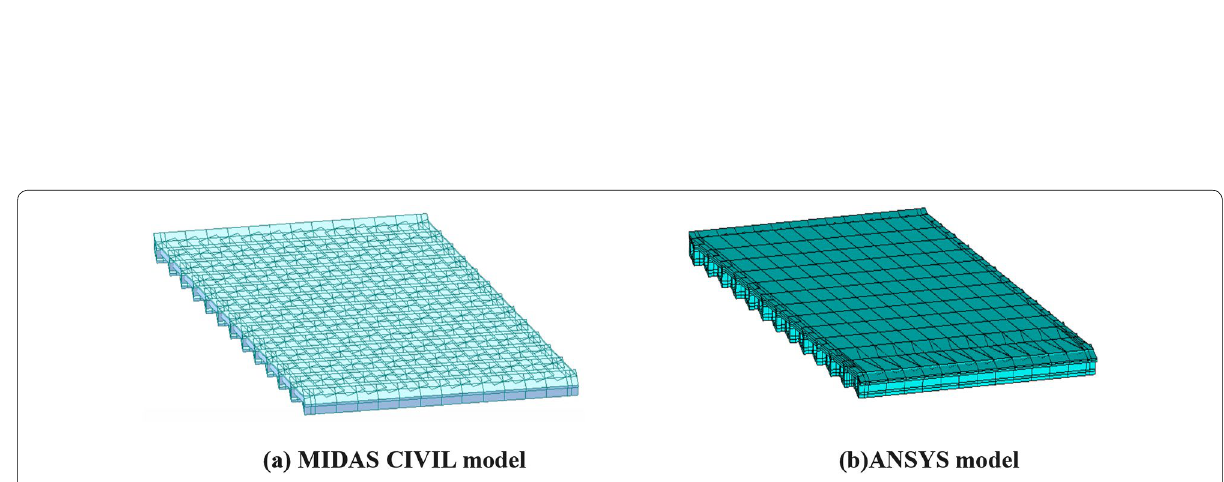
Fig. 9 Finite element